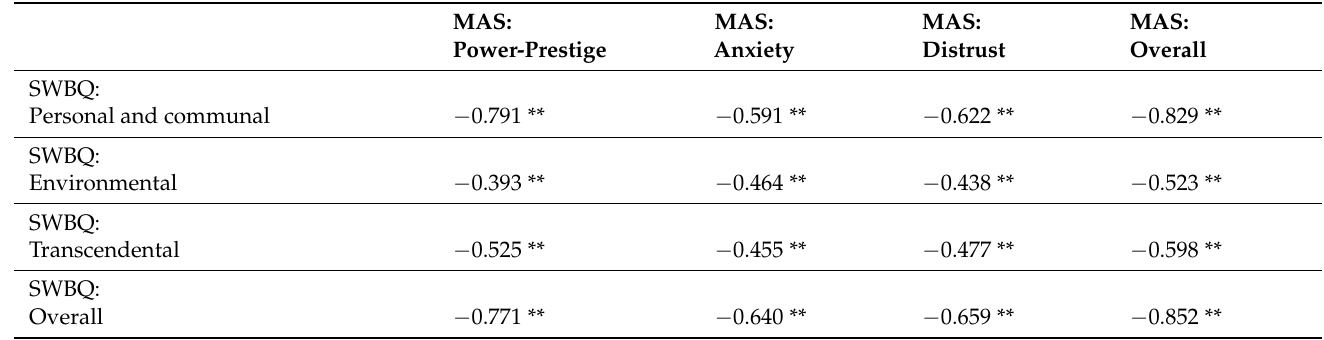
Table 5. Pearson Correlations between Scores on SWBQ and Scores on